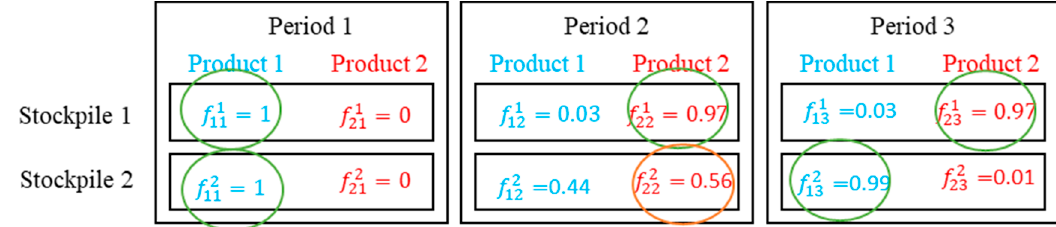
Figure 8. Process of setting to 1 the variables found after the first LP round. The green circles are the variable set to 1 because they are larger than the limit (0.7), and the red circle is the variable that will be set to 1 because it is the largest variable below the limit.